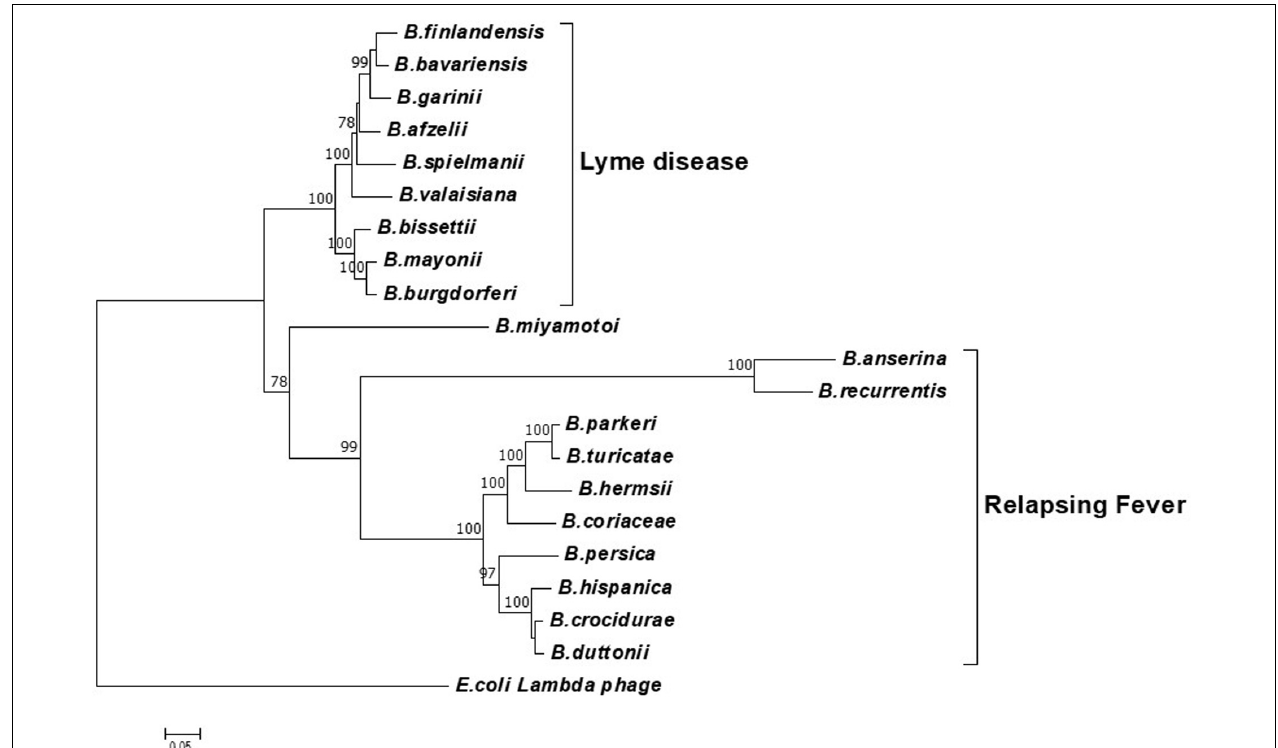
FIGURE 1 | A phylogenetic tree constructed based on the terL nucleotide sequence. The LD and RF Borrelia species and B. miyamotoi are separated into three well-supported clades. The Molecular Evolutionary Genetics Analysis (MEGA) package version 7 was used, and the tree was constructed via the neighbor-joining method. Scale bar represents the units of the number of base substitutions per site. Support for the clades was estimated via bootstrap analysis in MEGA with 3,000 replicates, values are indicated at the nodes (only values greater than 75 are displayed). The terL sequence from phage lambda was used as an outgroup to root the